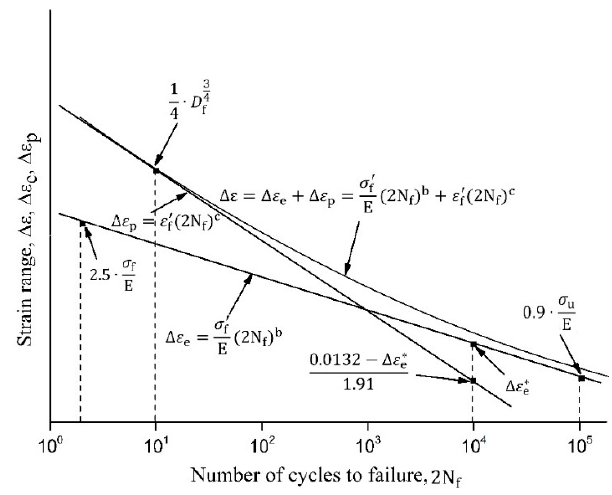
Figure 7. Four-point correlation method by Manson.